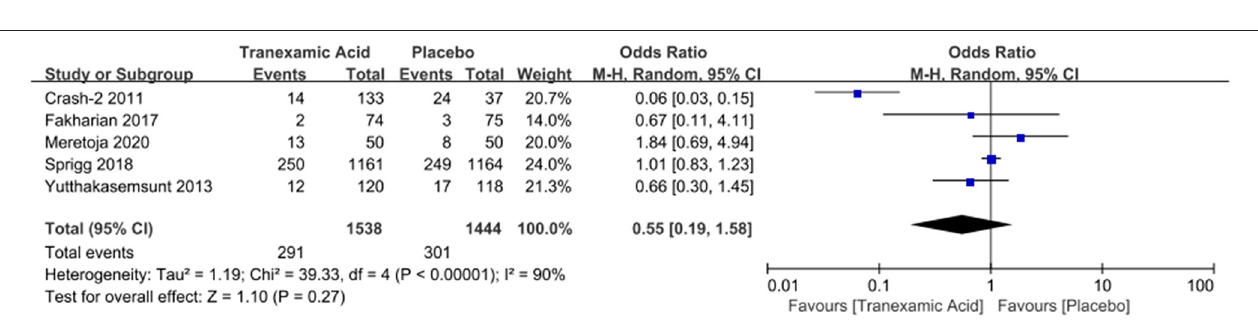
mean difference (WMD) for the volume (ml) of the hemorrhagic lesion was − 1.97 (95% CI: − 2.94 to − 1.00, I 2 = 14%; P